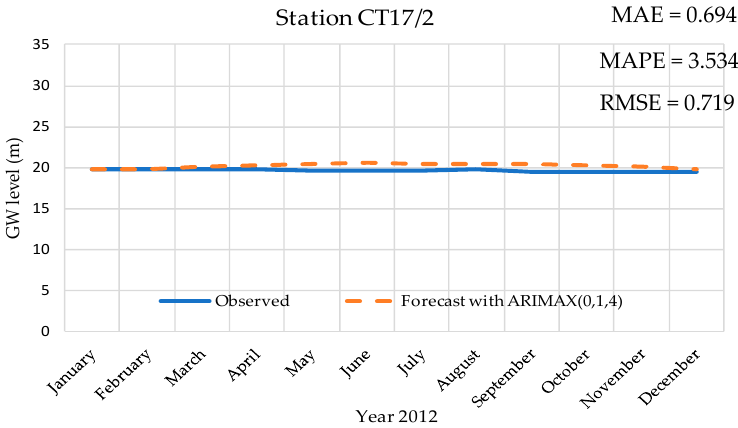
Figure 11. Comparison of groundwater level in the Ex-ante forecast by the ARIMAX(0,1,4) model for the CT17/2 station.